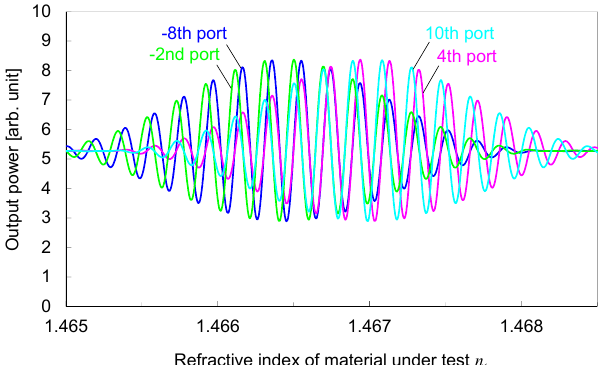
Figure 6. Output power from four output ports around focusing beams as a function of n t .